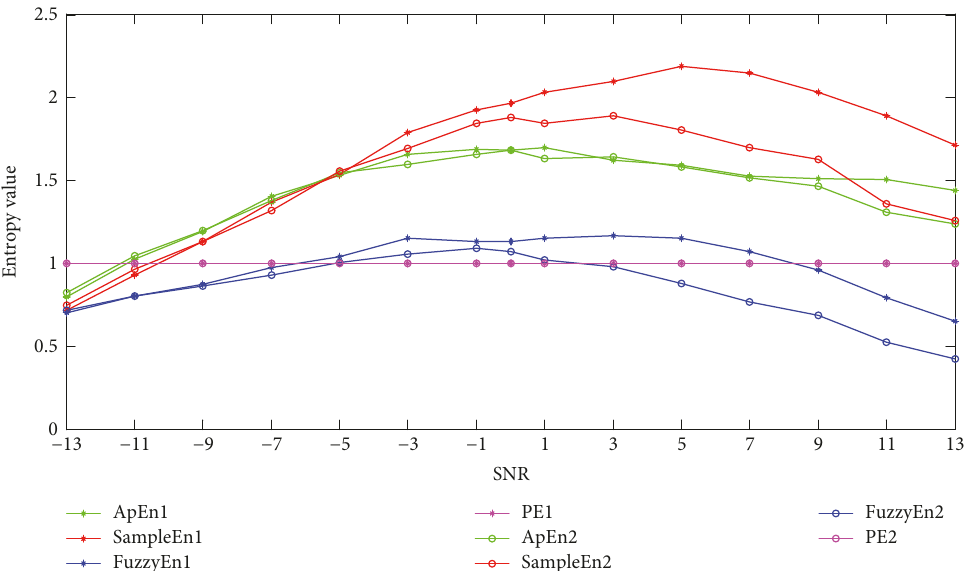
Figure 3: Four kinds of entropy values with di ff erent signal-to-noise ratios of